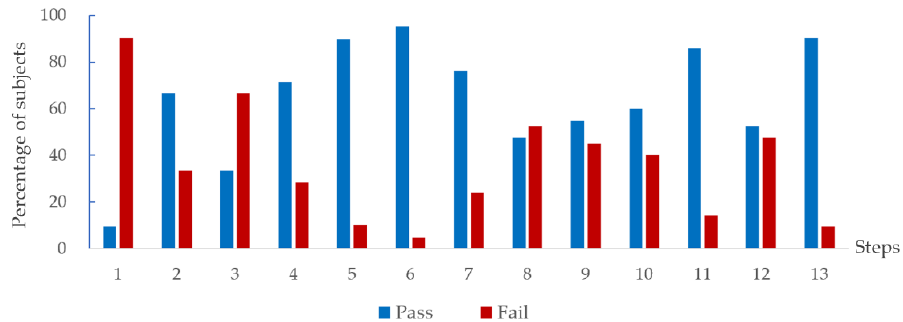
Figure 10. Percentage of passed and failed subjects at each step of terminology education.